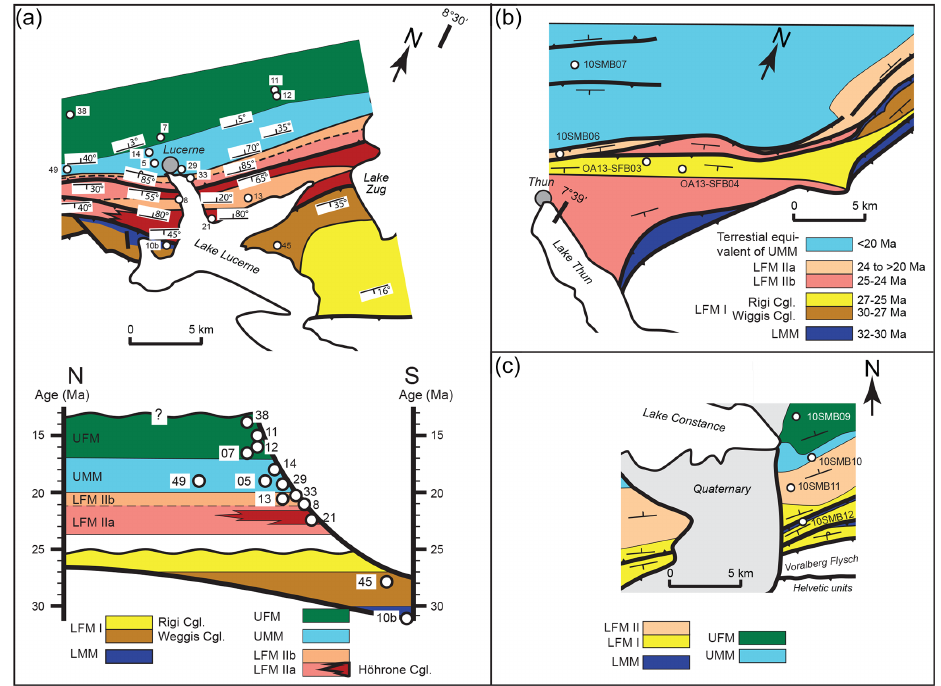
Figure 3. Stratigraphic units and sample locations of the three sampled sections. (a) Lucerne Section: geologic map and cross section modified from Schlunegger et al. (1997a). In both the map and the simplified cross section, sample numbers are only the last two digits of the sample numbers from Table 1. (b) Thun Section: geologic map modified from Schlunegger et al. (1993, 1996). (c) Bregenz Section: geologic map simplified from Oberhauser (1994), Kempf et al. (1999), and Schaad et al.